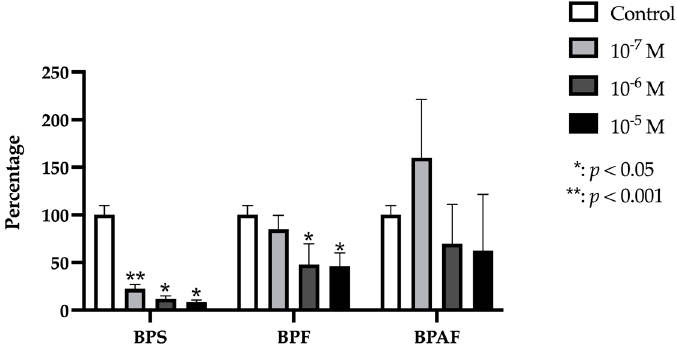
Figure 3. Expression of OSX in primary human osteoblasts treated for 24 h with bisphenol S, F, and AF (10 − 7 , 10 − 6 , or 10 − 5 M). The assay was performed in triplicate with each of the three primary human osteoblast cell lines. Data are expressed as percentage expression with respect to control ± standard deviation. Significant differences * p < 0.05; ** p < 0.001.